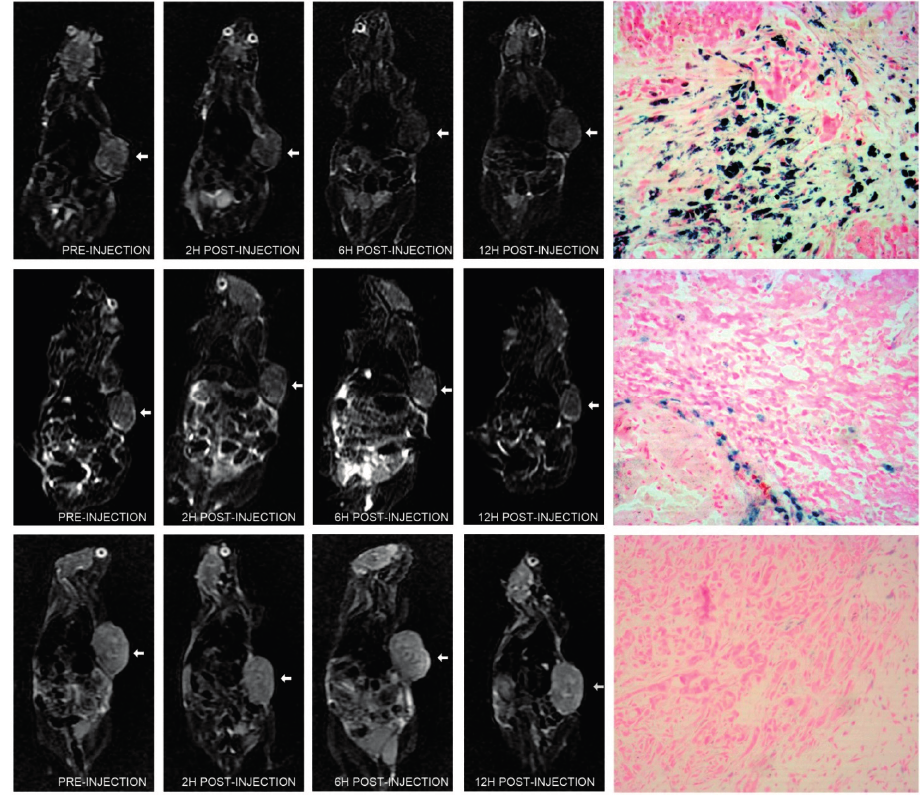
Figure 4. In vivo MRI images and histologic results. ( Top panel ) T2 weighted images of LNCaP tumor (arrow) pre-injection, different time point post-injection of polypeptide-SPIONs (Fe 3 O 4 , 0.240 mg/mL) and corresponding Prussian blue staining results (×100); ( Middle panel ) T2 weighted images of LNCaP tumor (arrow) pre-injection, different time point post-injection of non-targeted SPIONs (Fe 3 O 4 , 0.240 mg/mL) and corresponding Prussian blue staining results (×100); ( Bottom panel ) T2 weighted images of PC3 tumor (arrow) pre-injection, different time point post-injection of polypeptide-SPIONs (Fe 3 O 4 , 0.240 mg/mL) and corresponding Prussian blue staining results